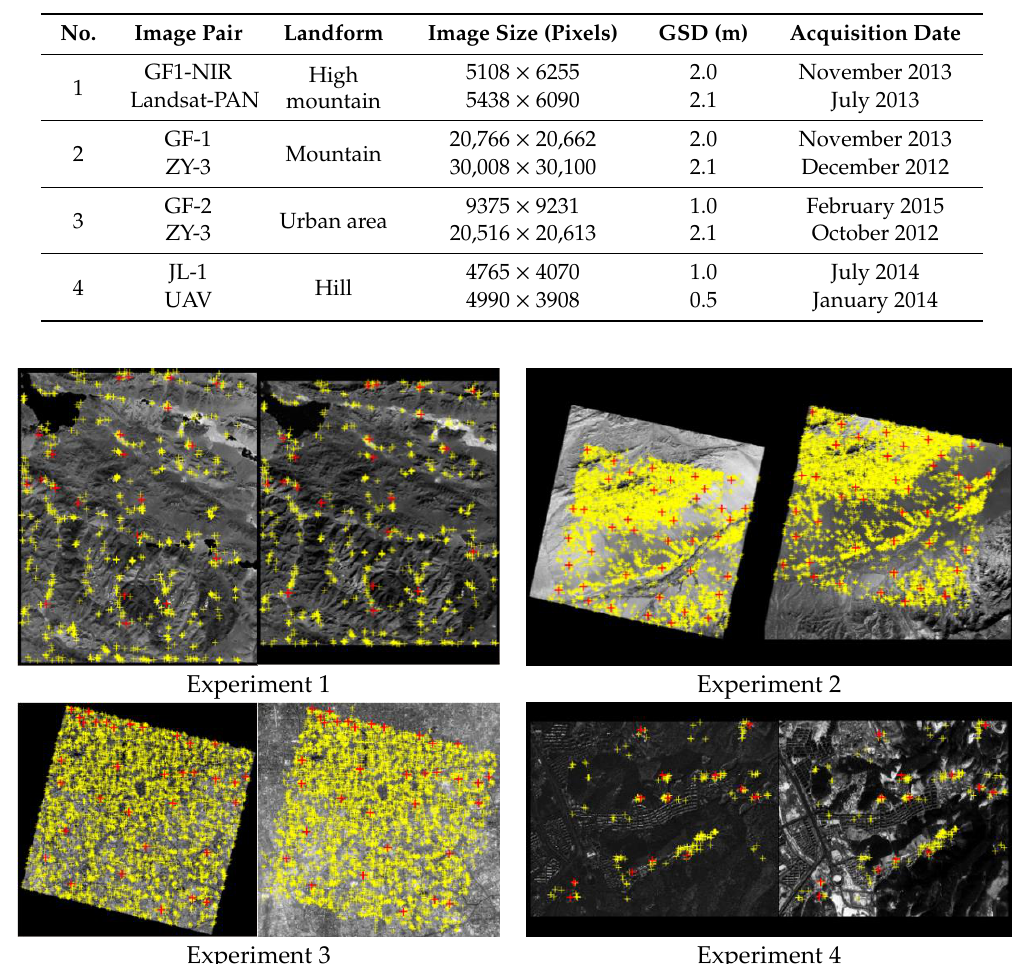
Figure 8. All the obtained matching points in the four complete image pairs. Yellow crosses represent the initial matching points and red crosses represent the checkpoints.